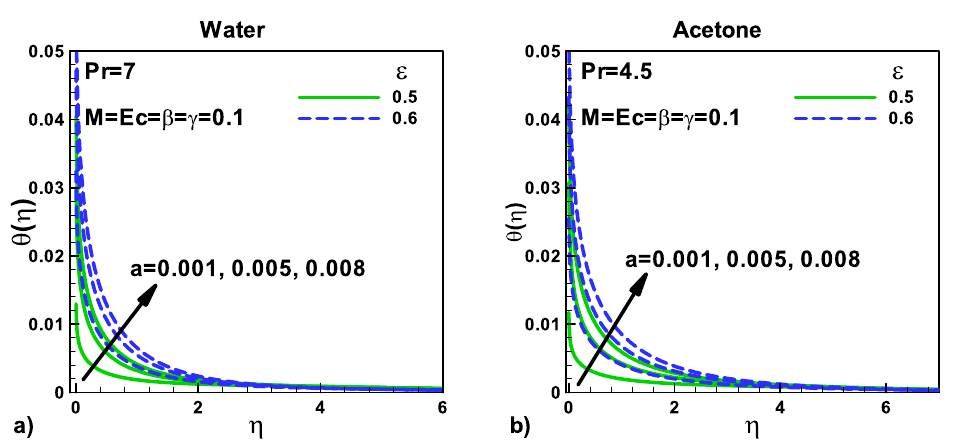
Figure 4. Effects of velocity ratio parameter on dimensionless temperature at different positions for ( a ) water ( b )